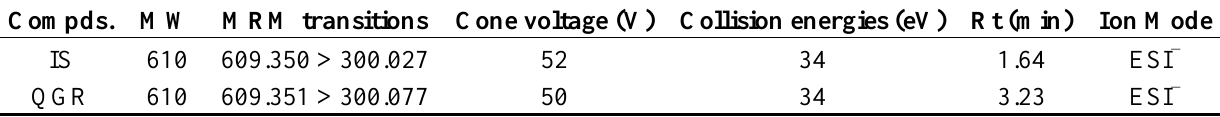
Table 1. The molecular weight (MW), MRM transitions, cone voltage, collision energies, retention times (Rt) and ion mode of QGR and